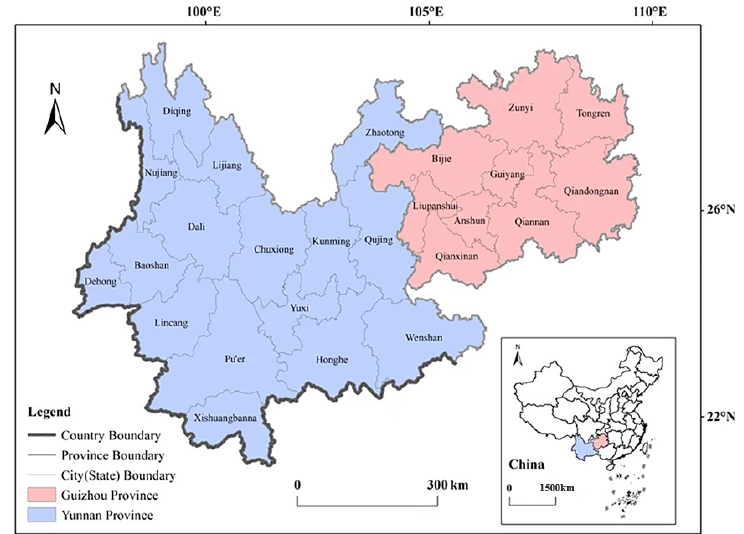
Figure 1. The Research Area of YGR. Note: The map is based on the standard map of GS (2020) 4619, downloaded from the standard map service website of the Ministry of Natural Resources. The base map is not modified, the same below.